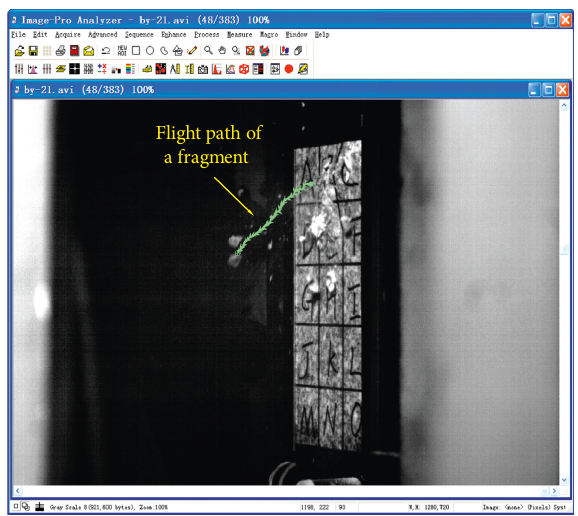
Figure 6: Analyzing the rate of the ejected fragment by using the Image ProPlus 7.0 (the average ejection rate can be calculated by v d / t , d is the length of the flight path and t is the time of the flight (cid:31) process).